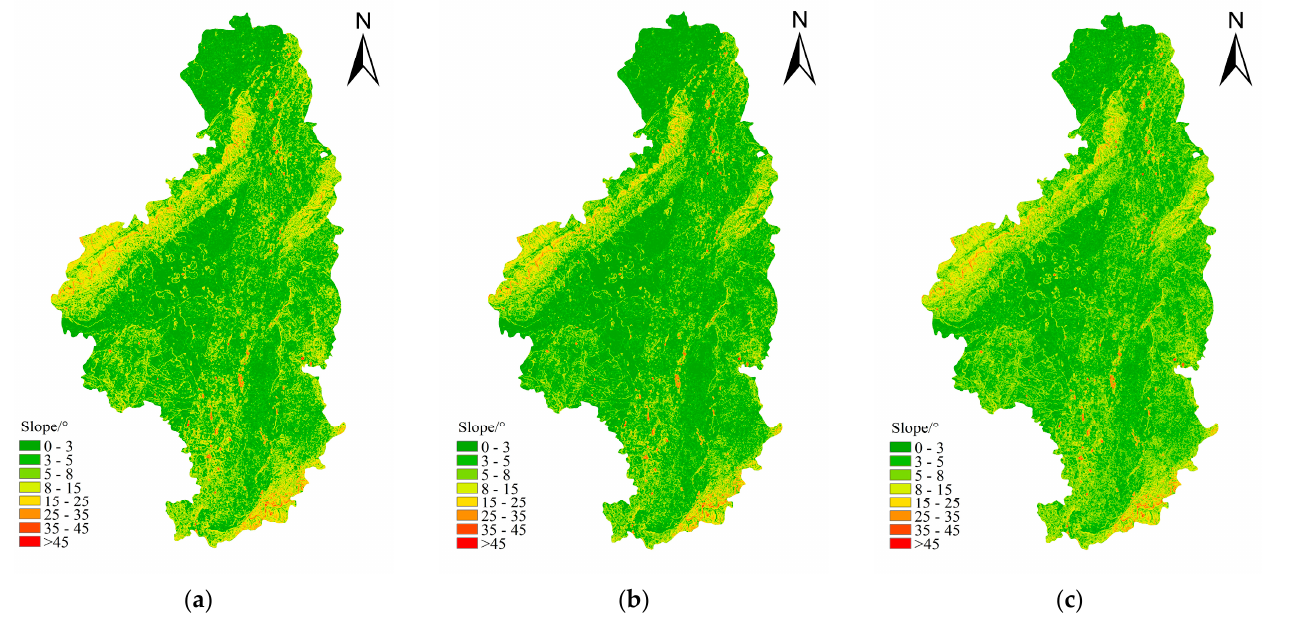
Figure 7. Slope maps extracted from three types of DEM data sources. ( a ) SRTM V4.1 DEM. ( b ) HYDRO1KDEM. ( c ) ASTER GDEM. Table 5. Topographic feature parameters of the three DEM